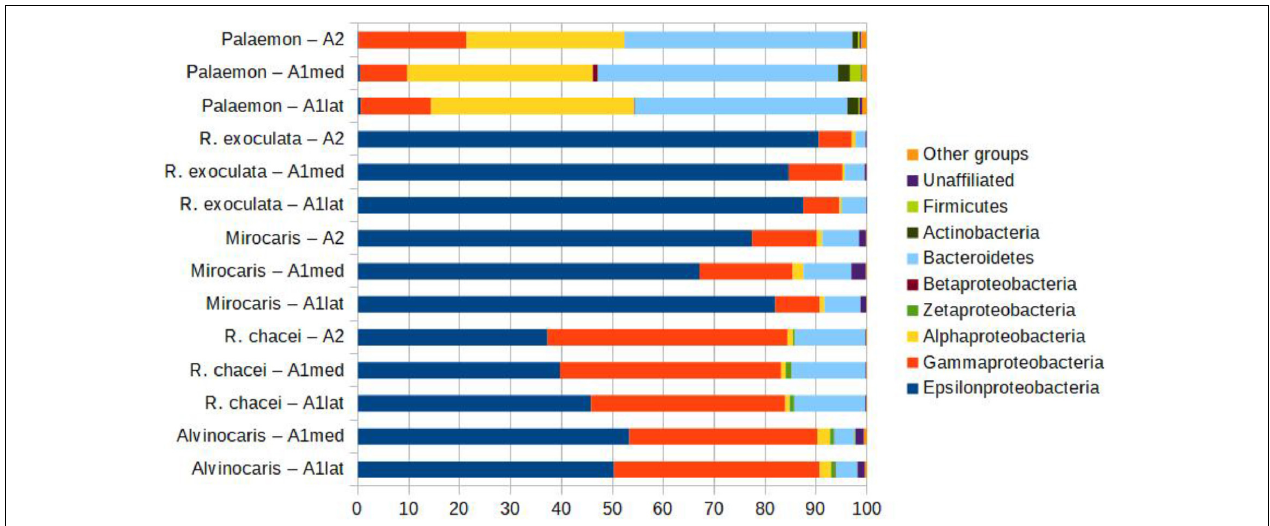
FIGURE 7 | Relative abundances of the different bacterial taxa in libraries obtained from the different appendages of the five shrimp species, showing the dominance of a limited number of groups. The category ‘other groups’ correspond to the groups that represent below 1% of the reads in all